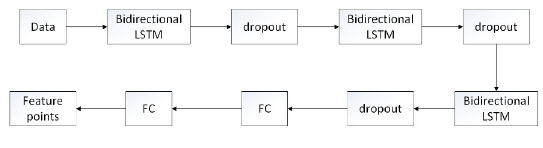
Fig. 1. LSTM model structure for detection of the feature points.